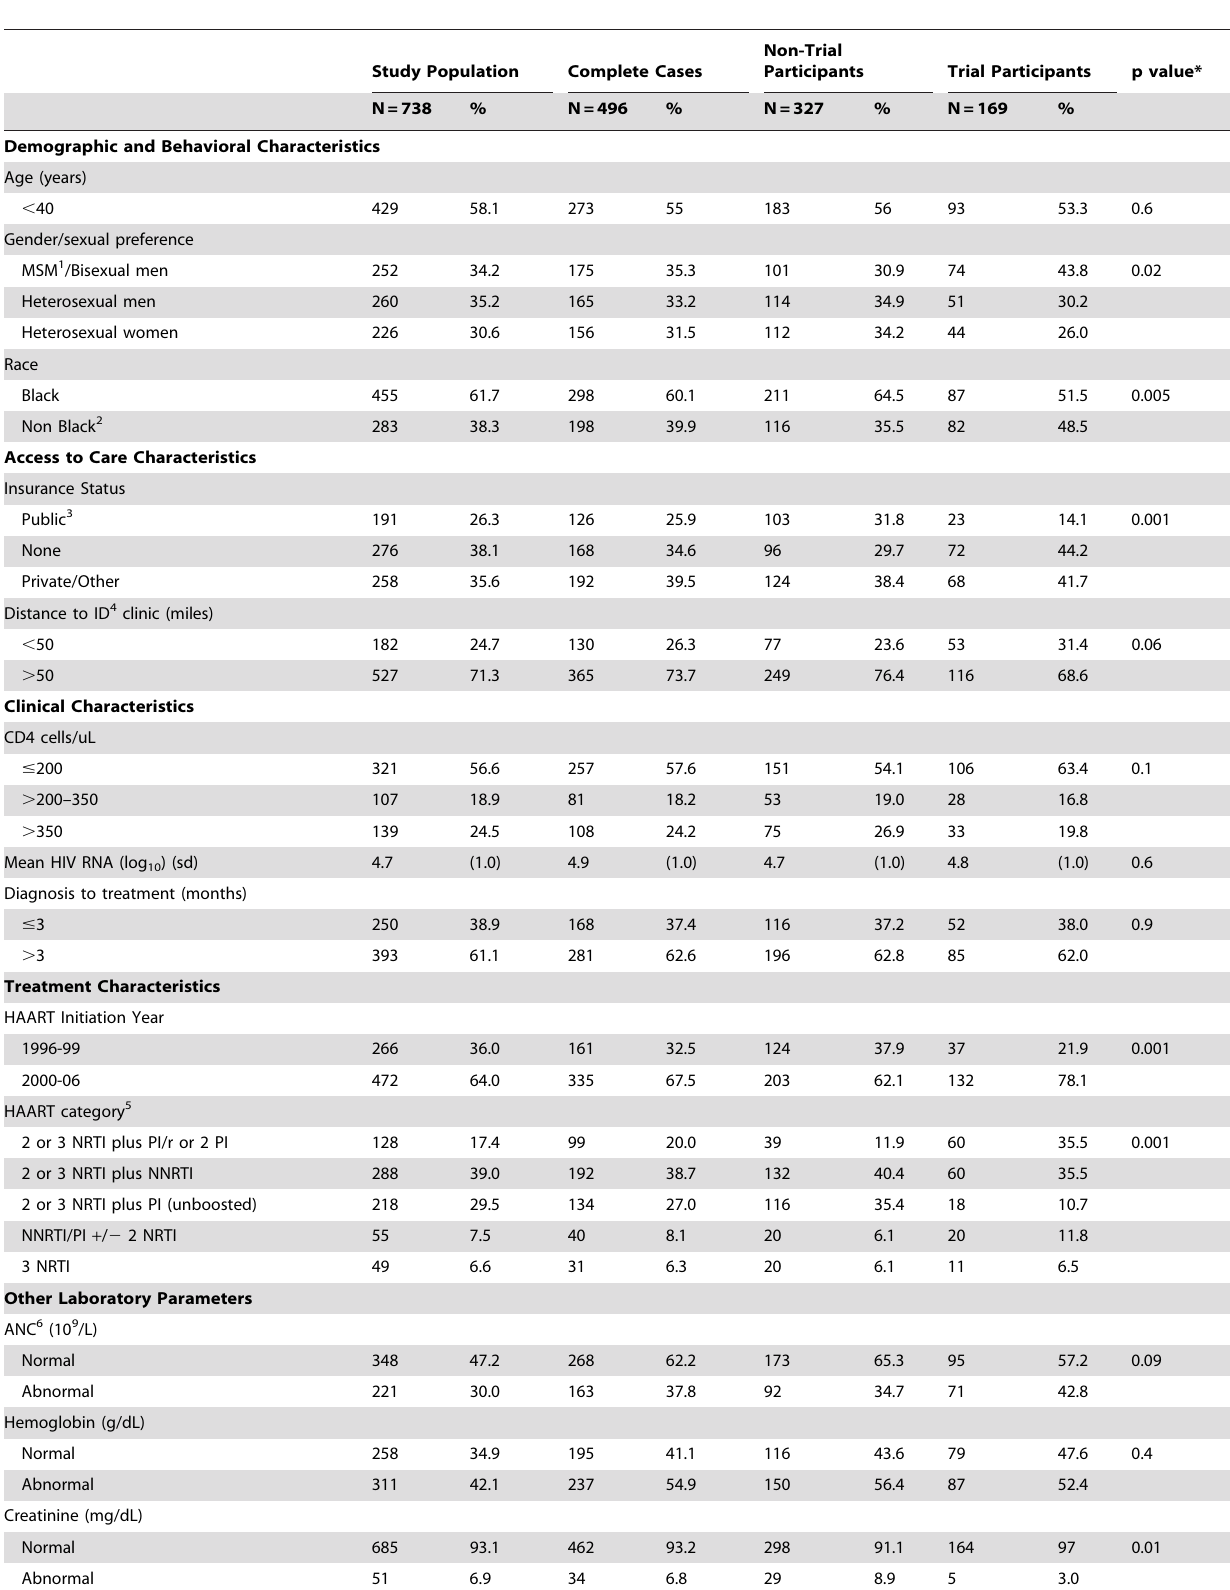
Table 1. Baseline sample characteristics for study population, complete cases and comparing trial to non-trial participants restricted to complete